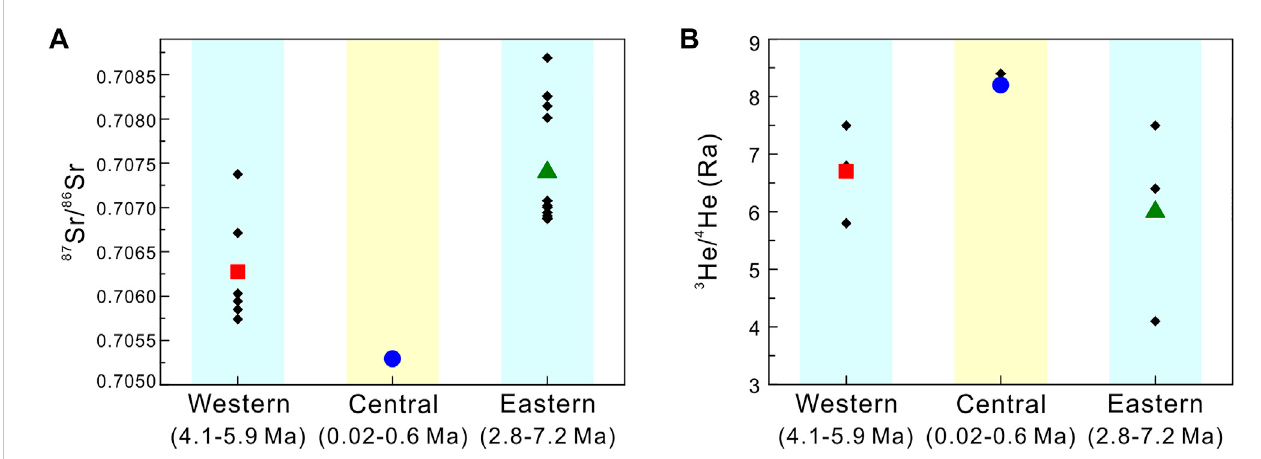
FIGURE 9 Covariance between lithospheric thickness and 87 Sr/ 86 Sr and 3 He/ 4 He ratios for the Tengchong basalts. Black diamonds denote measured data. The red rectangle, blue circle and green triangle represent average composition of samples from the west, middle and east, respectively. Light blue bands indicate thick lithosphere, and light yellow bands imply thin lithosphere. The ages are from previous studies (Mu et al., 1987; Guo et al., 2015; Zou et al., 2017; Cheng et al., 2020). The 3 He/ 4 He data are from Chen et al. (2022) and Zhang et al. (2021).